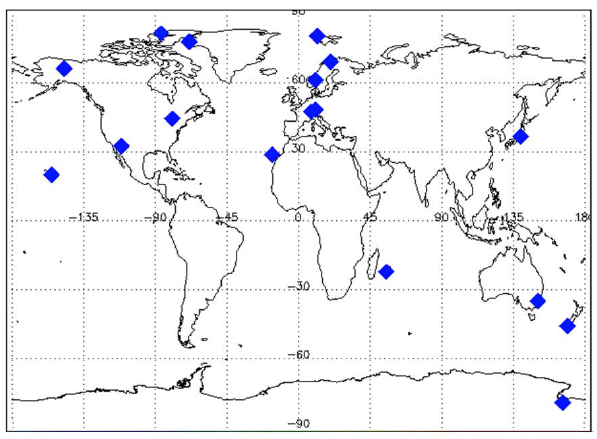
Fig. 2. Geographical distribution of the measurement sites.